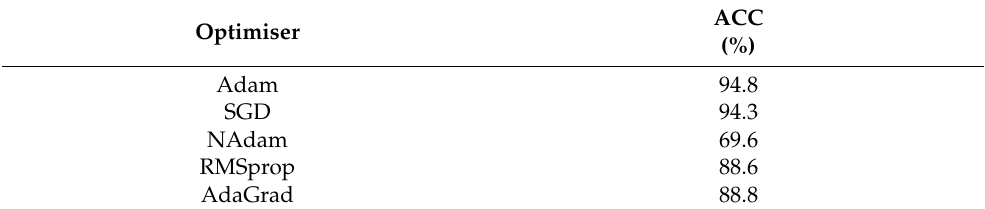
Table 6. When experimenting with alternative optimisation algorithms, ParaNet variations’ accuracy in distinguishing between normal and abnormal scans.